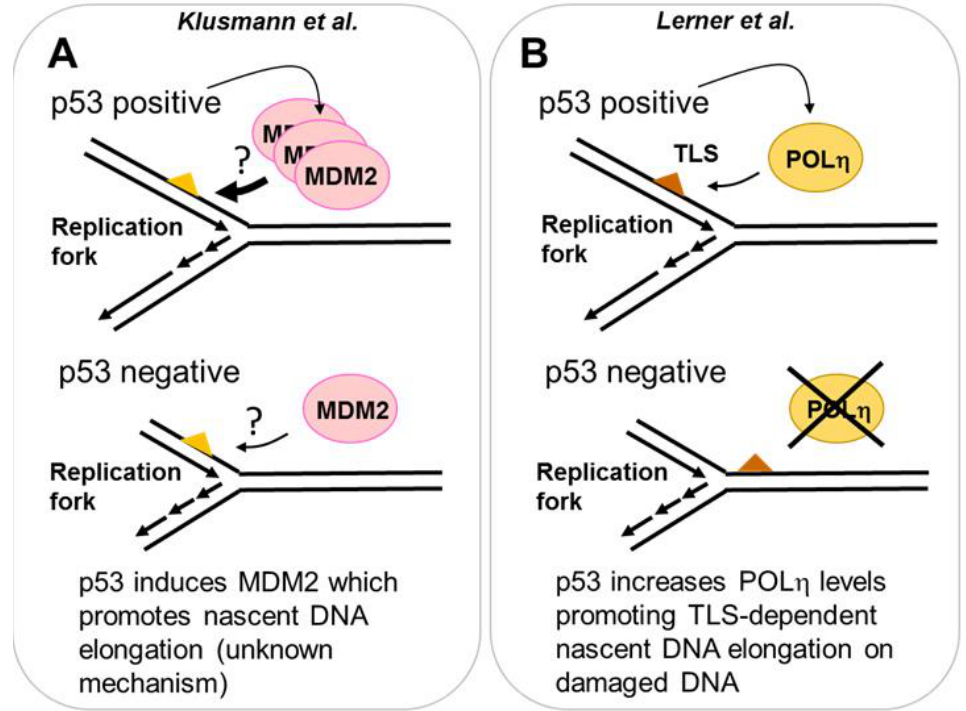
Figure 3. Transcription dependent role of p53 in DNA replication. ( A ) Using Nutlin-3a as an inducer of p53, a novel role of increased p53 levels on DNA replication was found. When Nutlin-3a treatment was combined with a source of replication stress (HU or gemcitabine), a role of MDM2 in the elongation of nascent DNA was revealed. Strikingly, in p53 negative cells, the MDM2 pathway that controls DNA replication is still active, despite the lack of p53-dependent induction of MDM2. The elimination of MDM2 in p53 negative cells reduces DNA elongation in such genetic background. ( B ) p53 induces the specialized POL η after UV irradiation. Cells with increased levels of POL η (generated by a pre-irradiation with low dose of UV) promote increased nascent DNA elongation. In p53 deficient cells, the p53 dependent induction of POL η is lost, nascent DNA elongation post-UV is impaired and the cell viability is reduced.